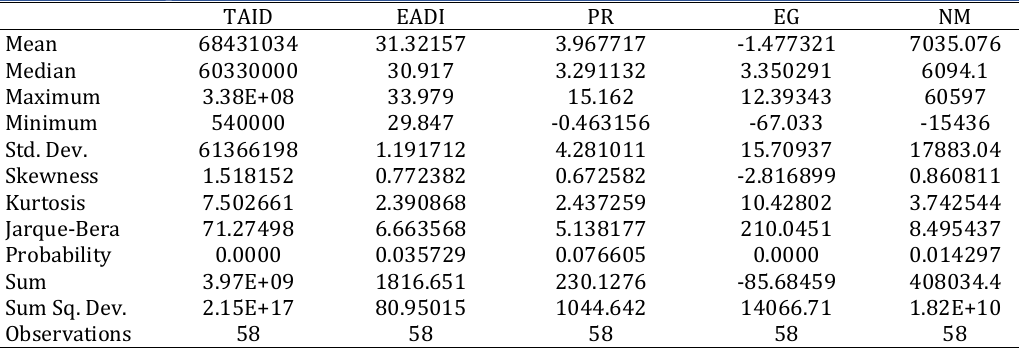
Table 2: Descriptive Statistics